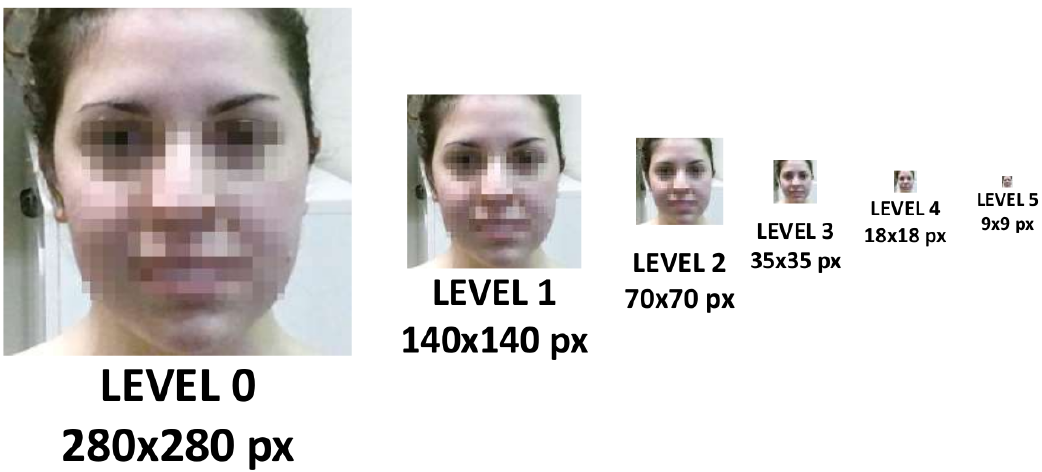
Figure 2. Spatial decomposition through the Gaussian pyramid of five levels with specific details on the pixel resolution. Since the dimensions of the square detected face area are not integer exponents of two, the size is rounded to the nearest